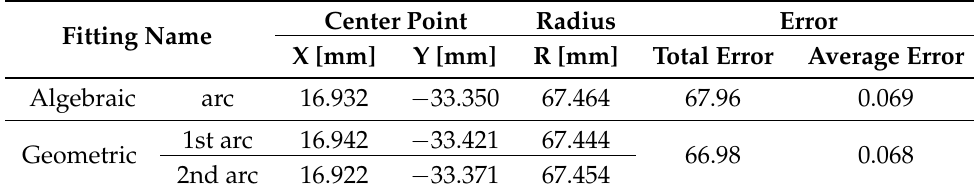
Table 3. Piecewise curve fitting results of the bean-curd gelatin phantom (in total, 985 points).